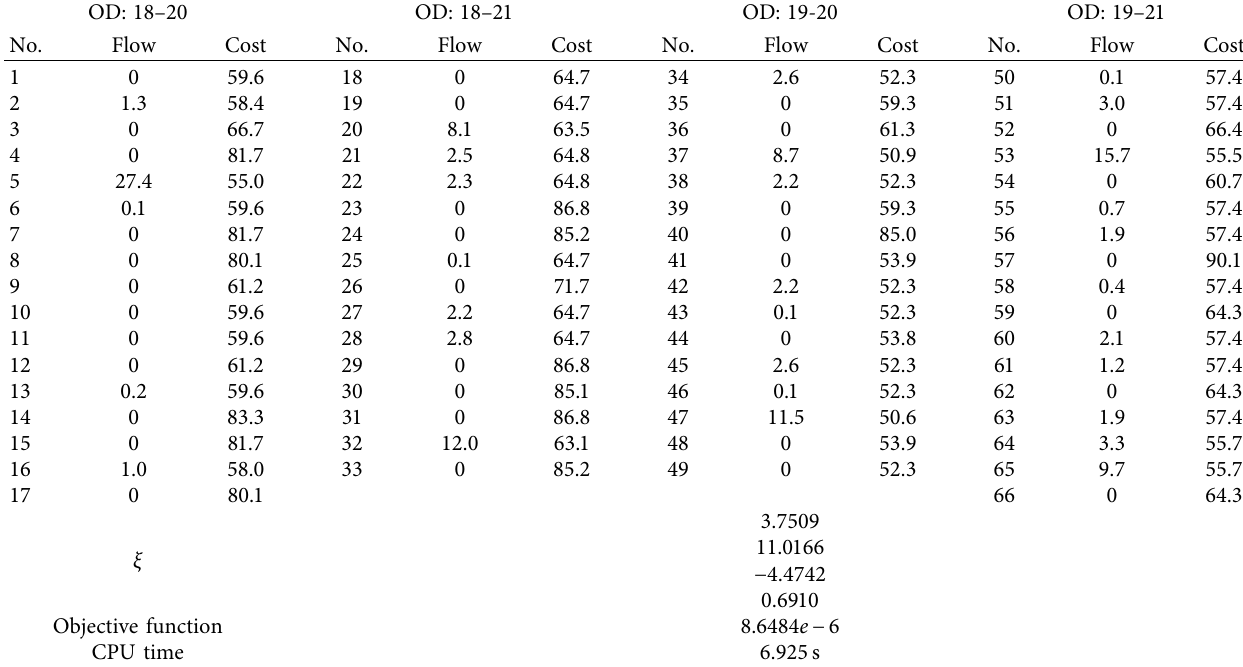
Table 4: Results of the fmincon solver.